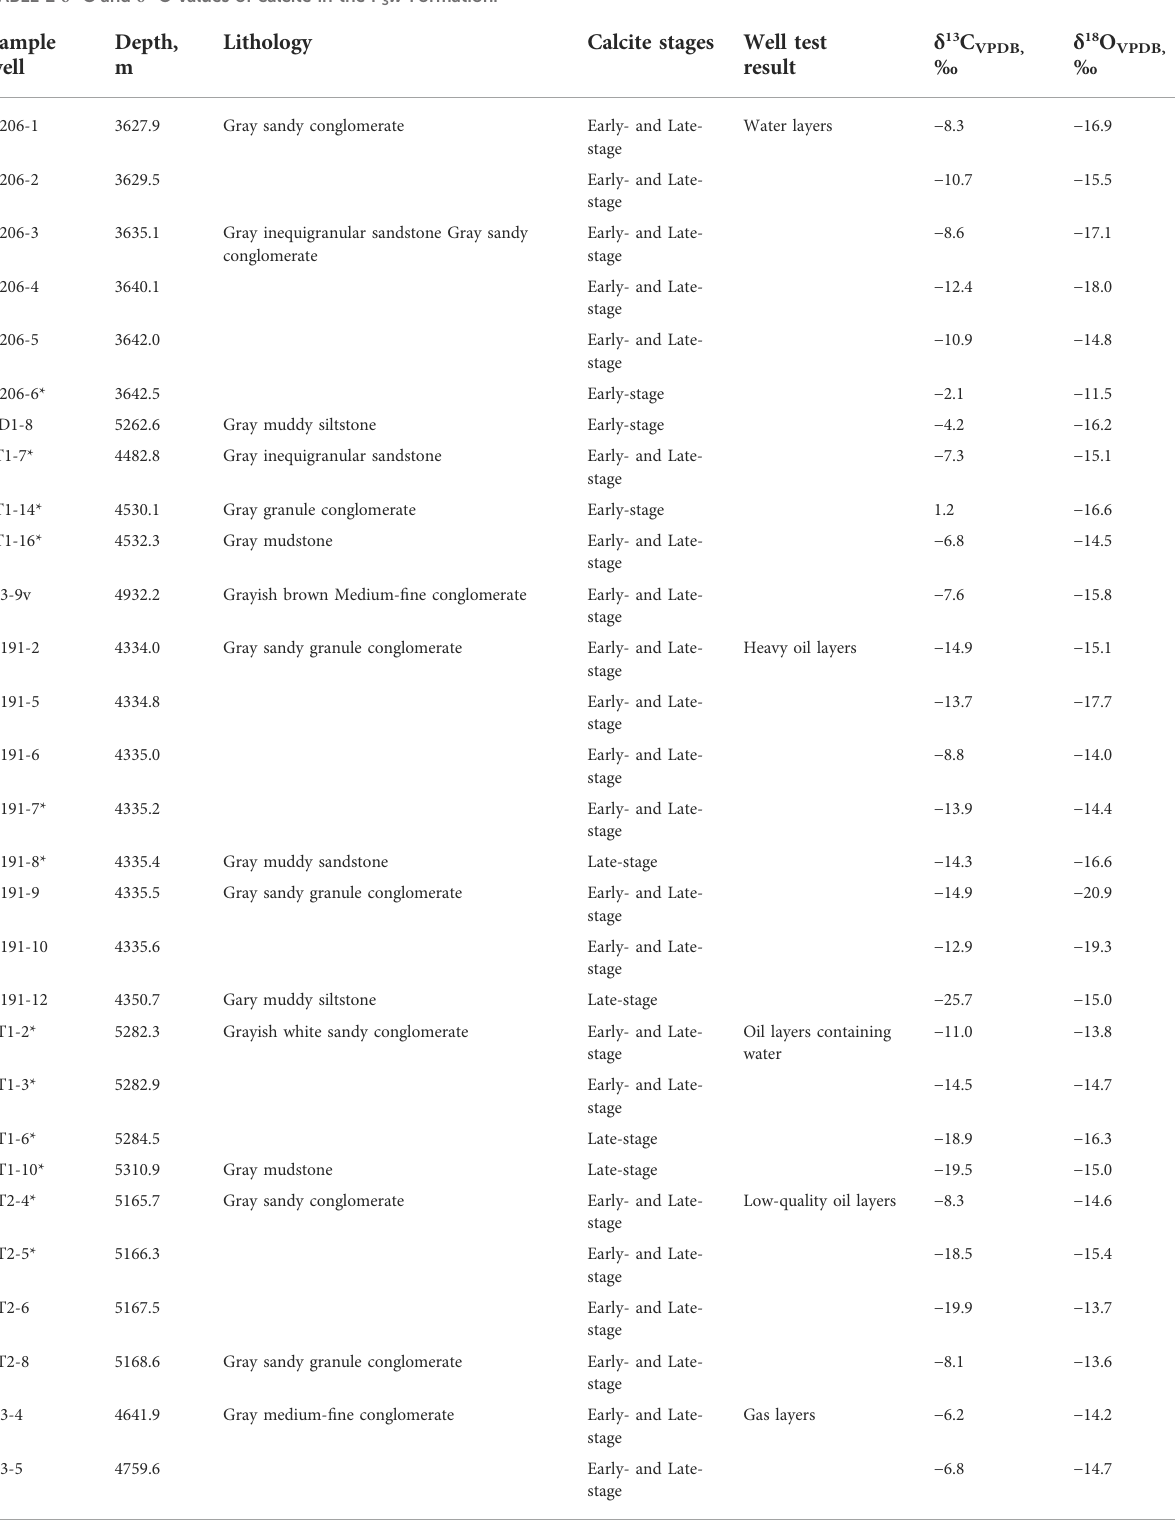
TABLE 2 δ 13 C and δ 18 O values of calcite in the P 3 w